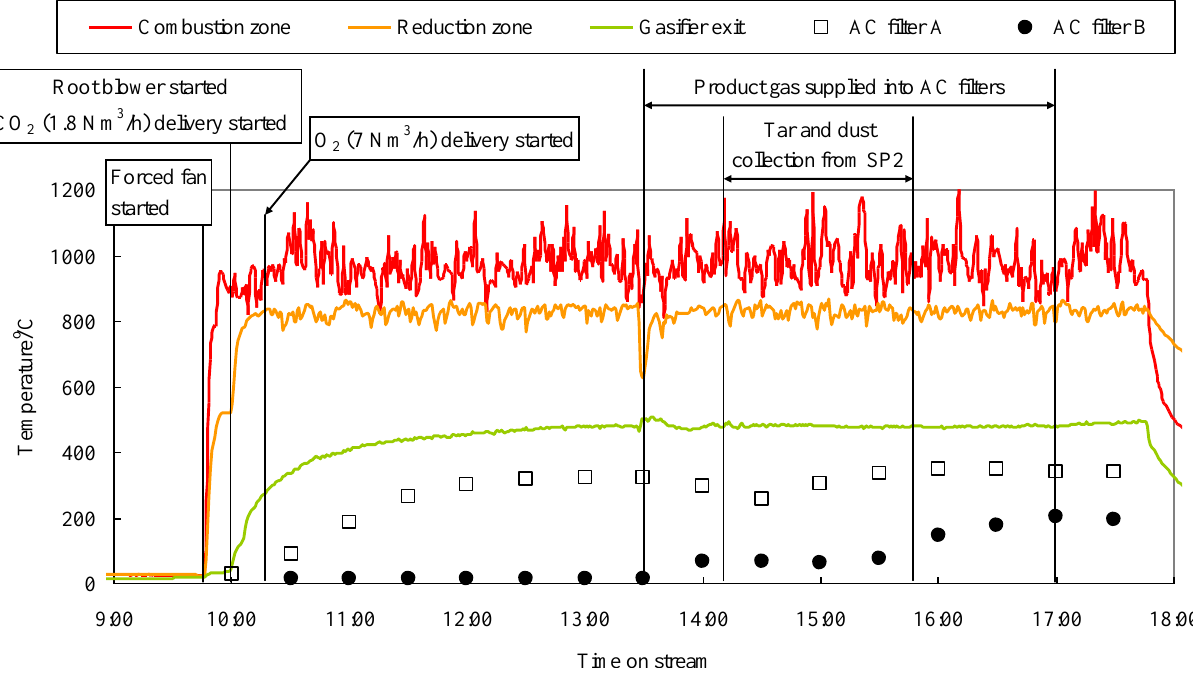
Figure 6. Change in temperatures of gasifier and activated carbon filters as a function of